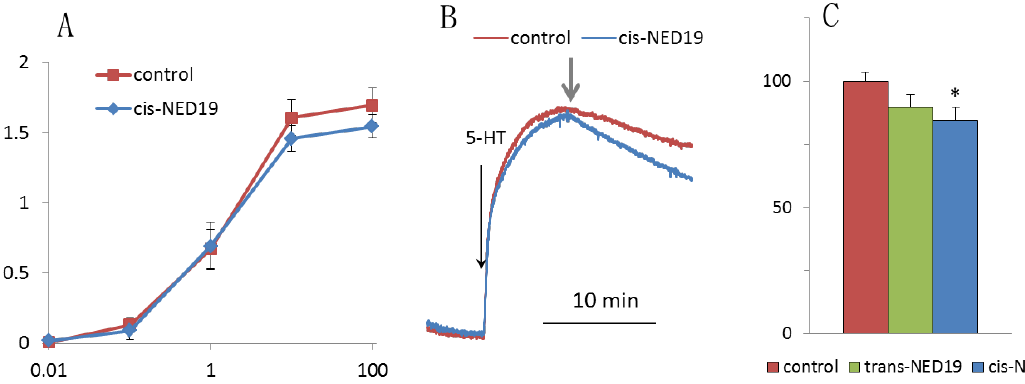
Figure 11. The effect of NED 19 on the force of aorta contraction in response to 5-HT. ( A ) Dependence of maximal contraction force on 5-HT concentration in the absence and presence of cis -NED 19. ( B ) Effect of cis -NED 19 on the force of aortic ring contraction in the tonic phase. Short arrow indicates addition of cis -NED 19 or vehicle. ( C ) Extent of inhibition of tonic contraction after 10 min incubation with NED 19 isomers is shown. Concentrations of cis - and trans -NED19 were 30 μM. Each value in panels A and C is a mean + SEM from the six independent experiments.